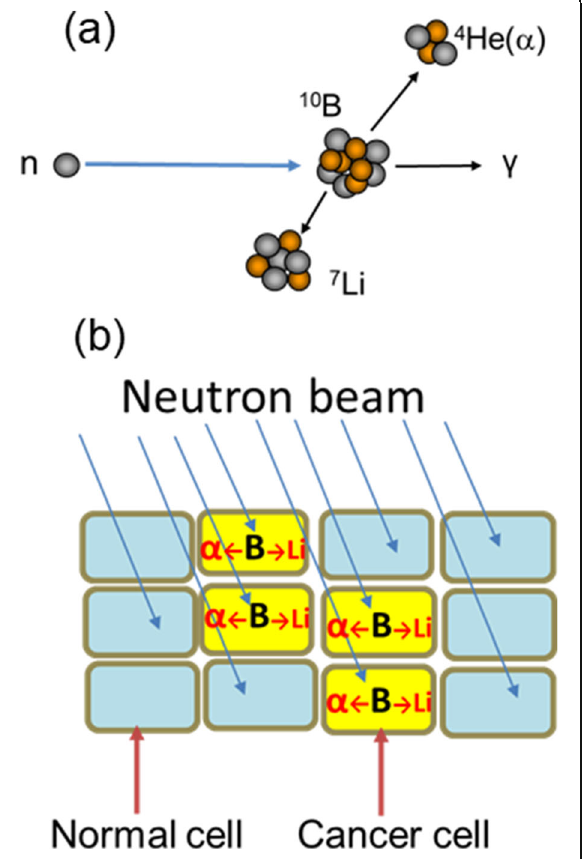
Fig. 19 n- 10 B reaction ( a ) and schematic diagram of BNCT principle ( b